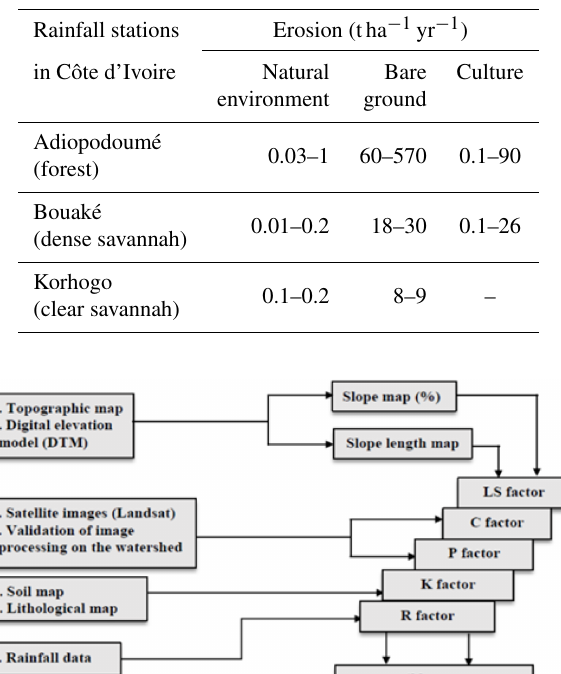
Table 2. Erosion values by vegetation cover in Côte d’Ivoire (Roose and Lelong, 1976).